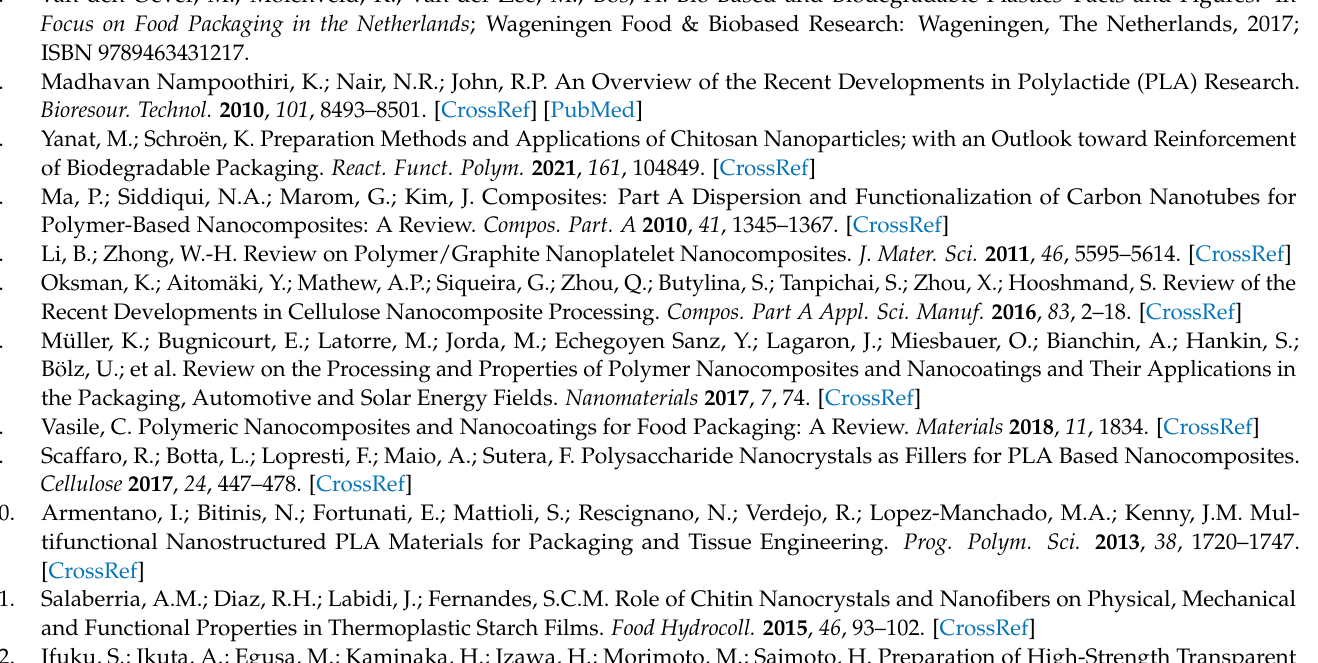
Figure A4 . Scanning Electron Microscopy Picture of Neat PLA. Figure A4. Scanning Electron Microscopy Picture of Neat